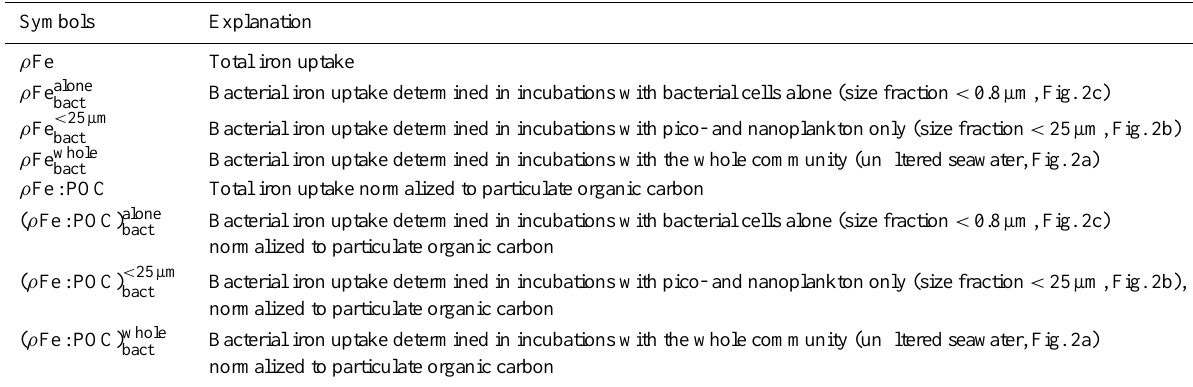
Table 2. List of abbreviations used. Symbols Explanation ρ Fe Total iron